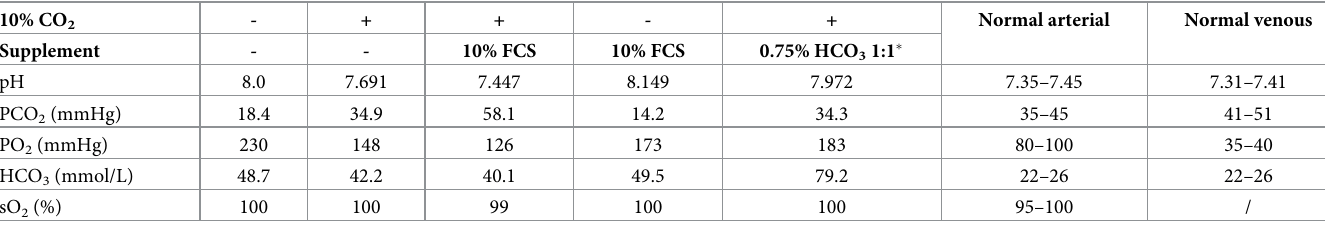
Table 4. Gas analysis of the sDMEM media under the different growth